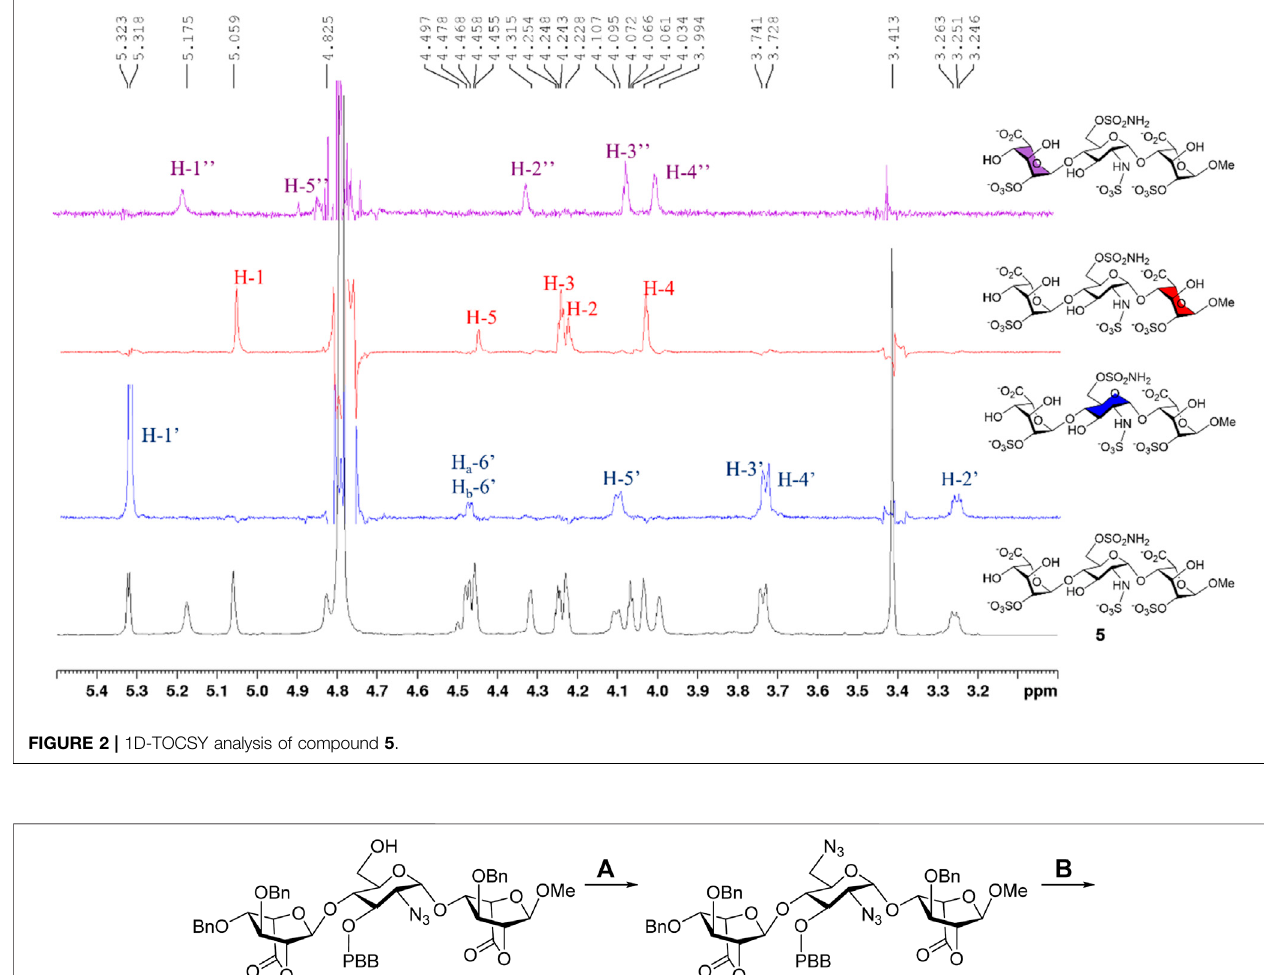
FIGURE 2 | 1D-TOCSY analysis of compound 5